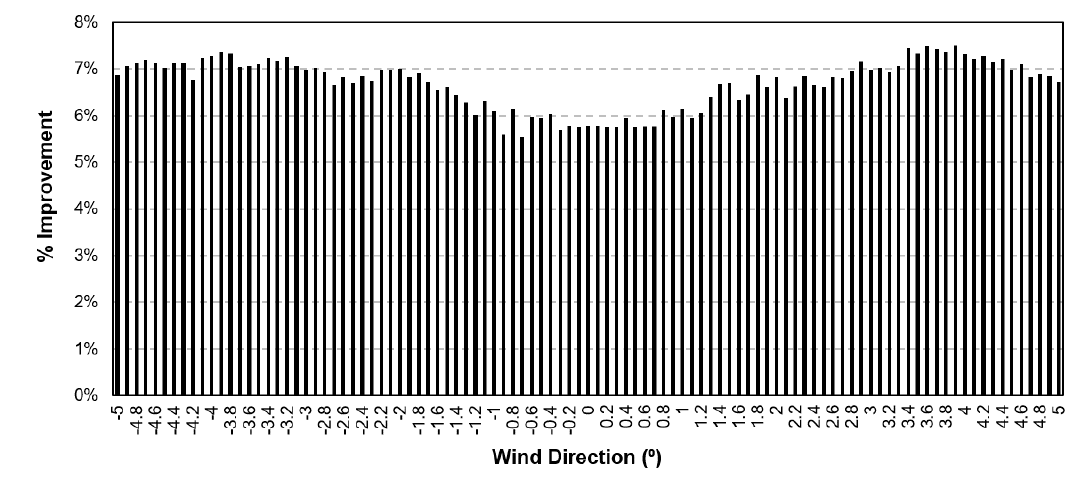
Figure 7. Percent improvement in power production between wind directions − 5 ◦ to 5 ◦ at 0.1